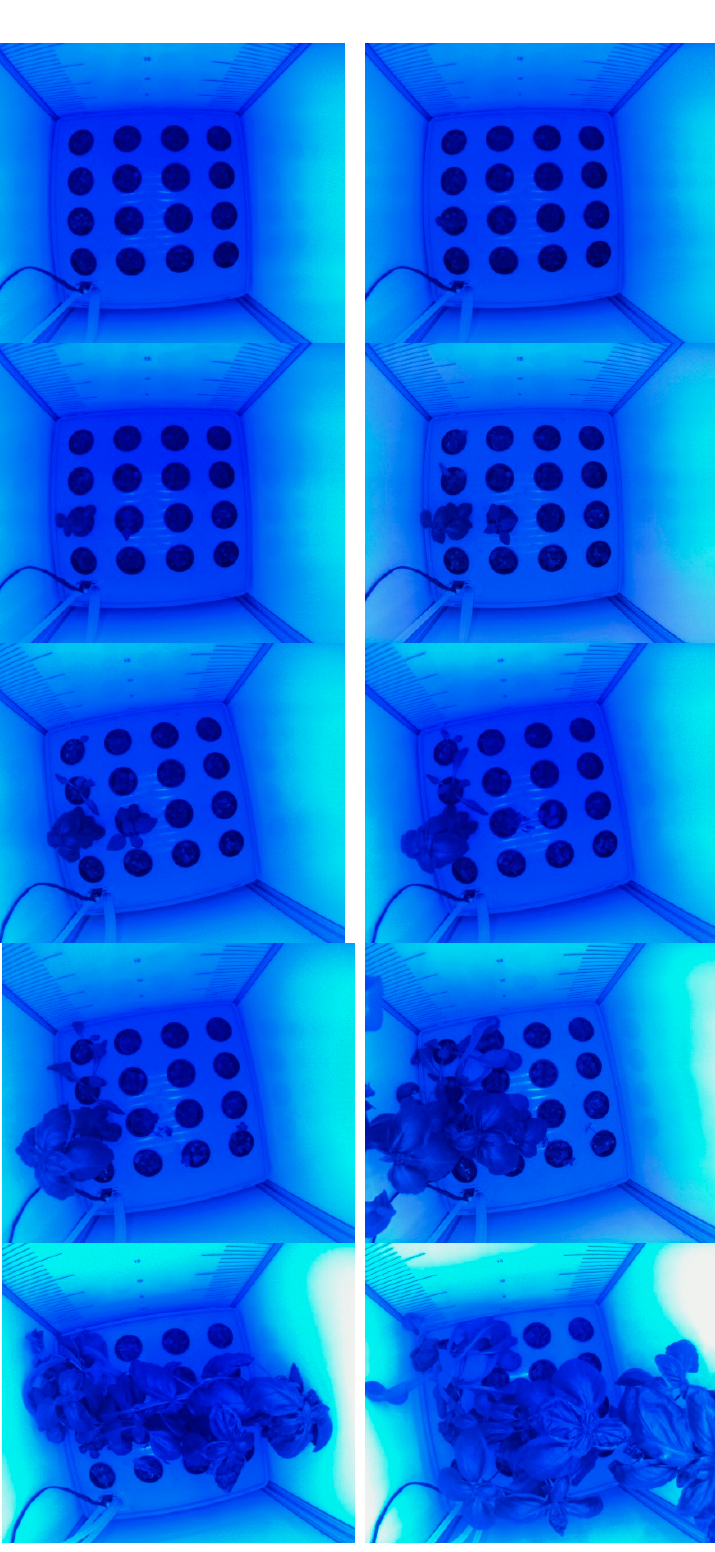
Figure 15. Photos from the camera mounted inside one of the GrowBots showing the growth of a basil plant in a GrowBot during 43 days (images from the last 35 days). basil plant in a GrowBot during 43 days (images from the last 35